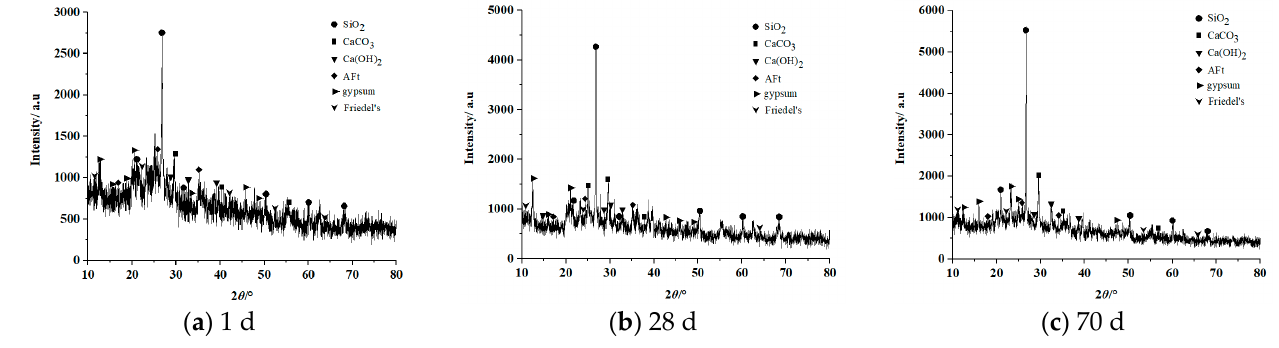
Figure 8. XRD patterns of T5 specimen at 1 d, 28 d, and 70 d.